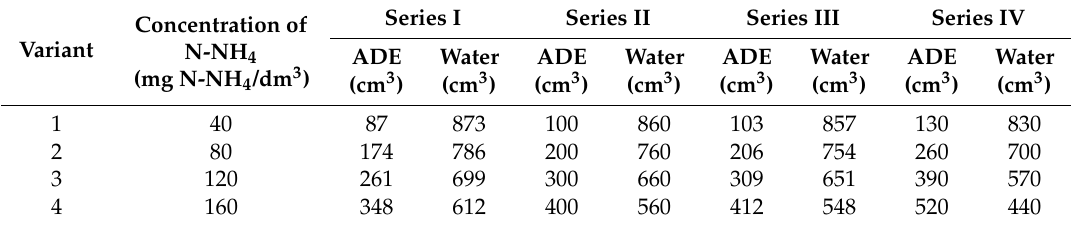
Table 2. The volume of ADE and deionized water introduced to the